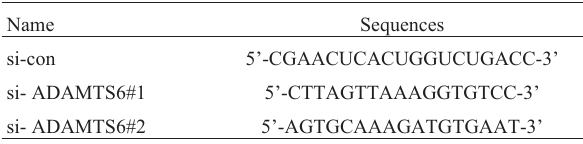
Table 1 - The sequences used in cell transfection.